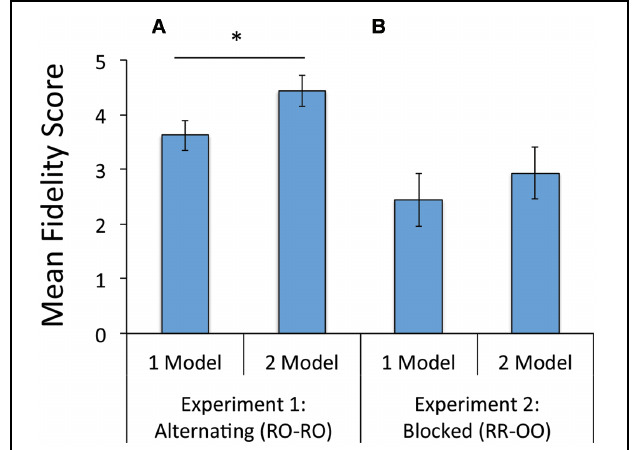
FIGURE 2 | Mean imitation fidelity score in the 1 and 2 model demonstrations conditions: (A) Experiment 1 and (B) Experiment 2. ∗ p <